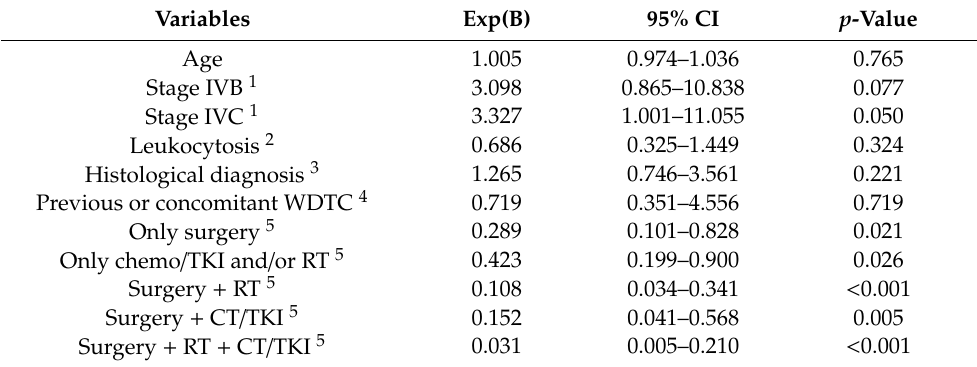
Table 2. Multivariate